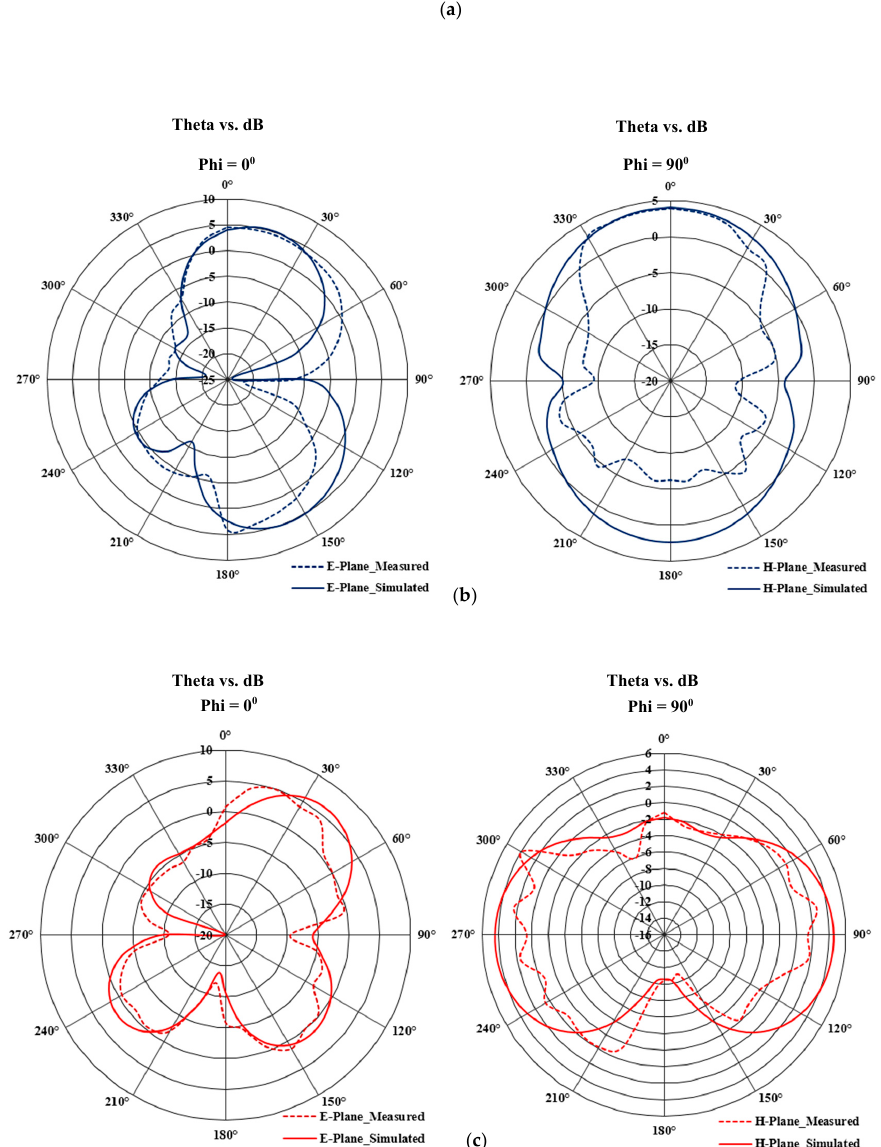
Figure 12. Simulated and measured E- & H-plane RP ( a ) 3.5 GHz ( b ) 6.1 GHz ( c ) 9.25 GHz.